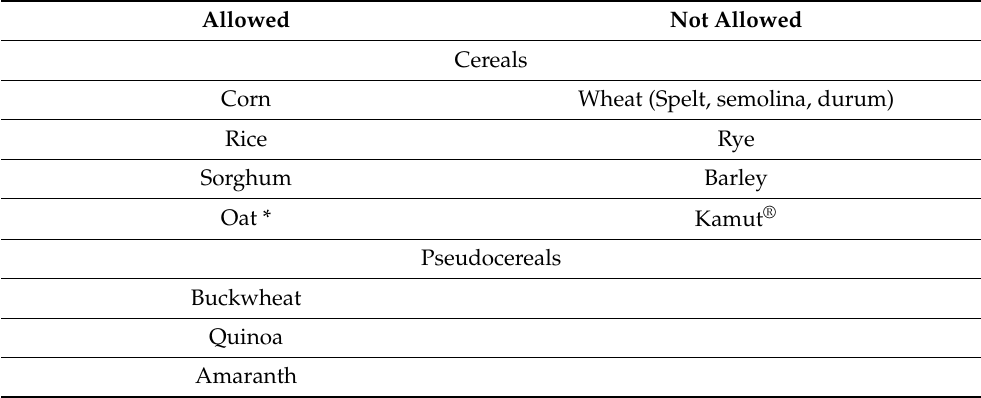
Table 1. Cereals and pseudocereals and their inclusion in the GFD.